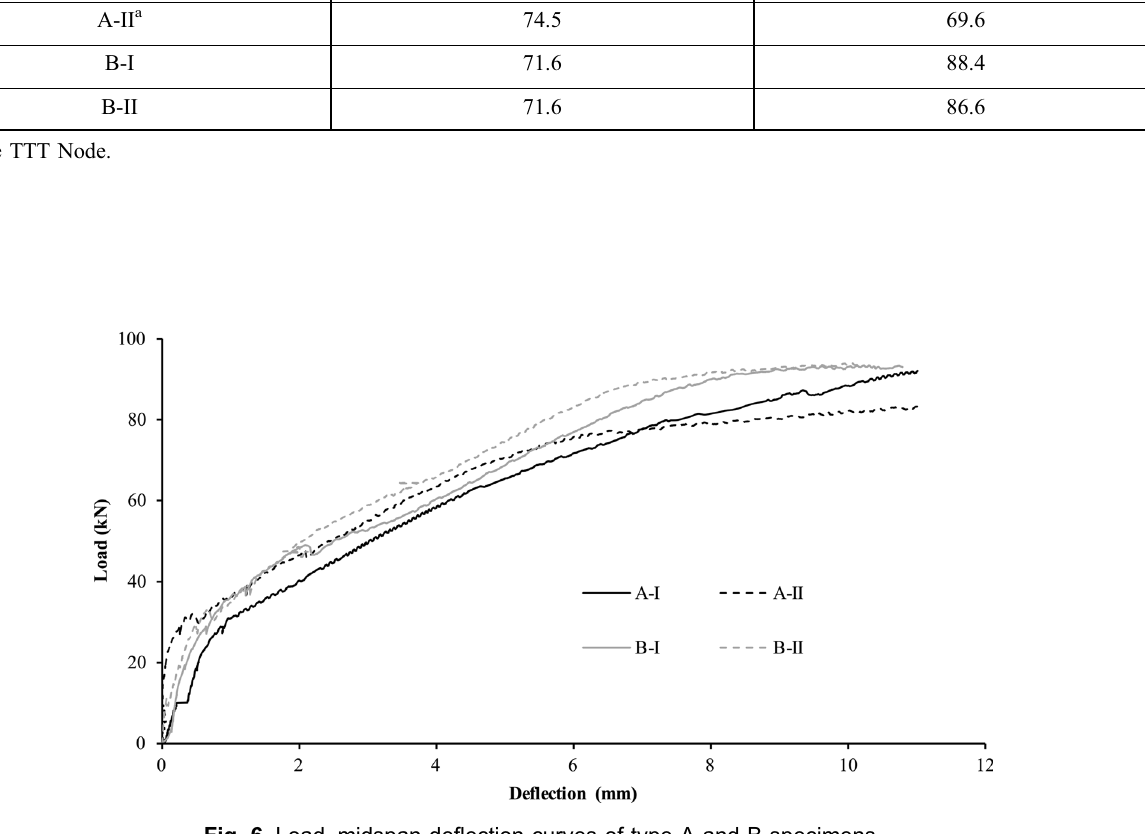
Fig. 6 Load–midspan deflection curves of type A and B